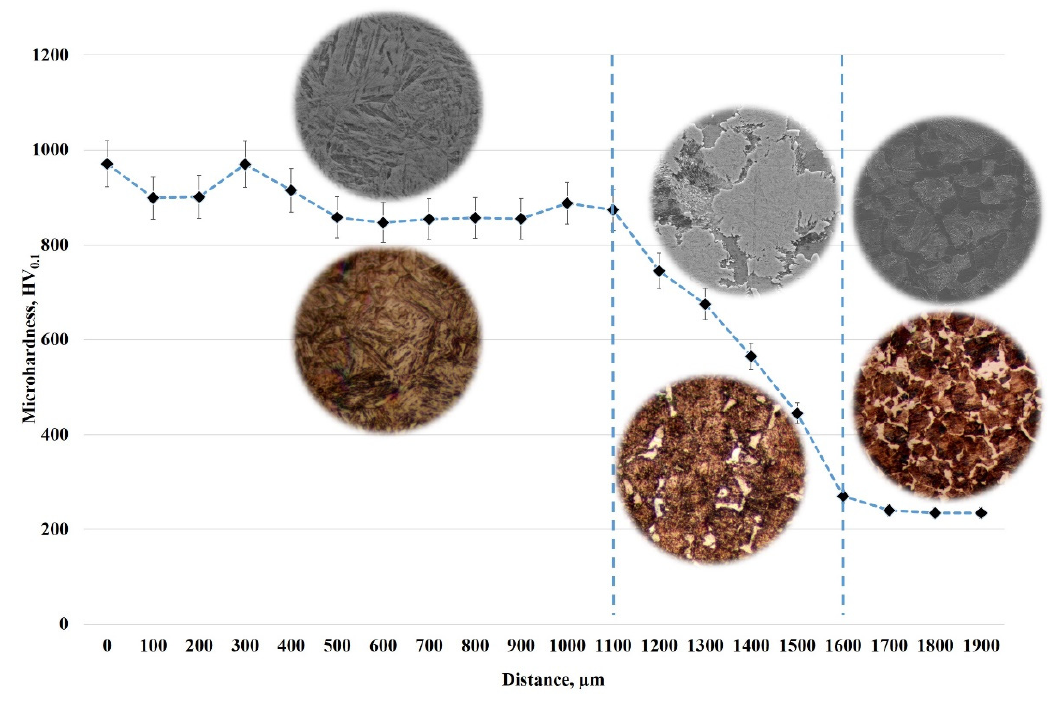
Figure 9. Depth distribution of microhardness in sample No.2 after EPTCH.